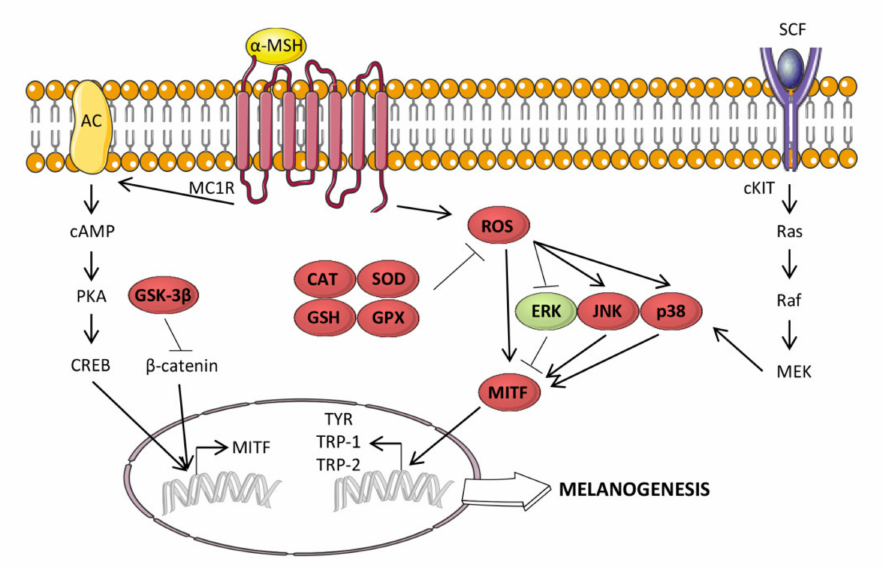
Figure 2. EOs and their components reduce melanogenesis and oxidation through interconnected mechanisms. Superoxide dismutase (SOD), glutathione peroxidase (GPX), catalase (CAT), glutathione (GSH), reactive oxygen species (ROS), α -melanocyte stimulating hormone ( α -MSH), melanocortin 1receptor(MC1R),adenylylcyclase(AC),stemcellfactor(SCF),microphthalmia-associatedtranscription factor (MITF), tyrosinase (TYR), tyrosinase-related protein -1 (TRP-1) and -2 (TRP-2), glycogen synthase kinase 3 β (GSK3 β ), c-Jun N-terminal kinase (JNK), extracellular signal-regulated kinase (ERK). Proteins that are upregulated by EOs or their components are reported in green, proteins that are downregulated by EOs or their components are reported in red. Parts of the figure are drawn using pictures from Servier Medical Art (https: //